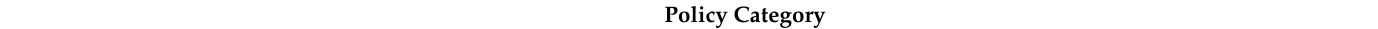
Table 1. Prevalence of flavored tobacco product availability in San Francisco Bay Area retail stores over time and by flavored tobacco sales policy category, 2014–2020 San Francisco Bay Area Young Adult Health Surveys.